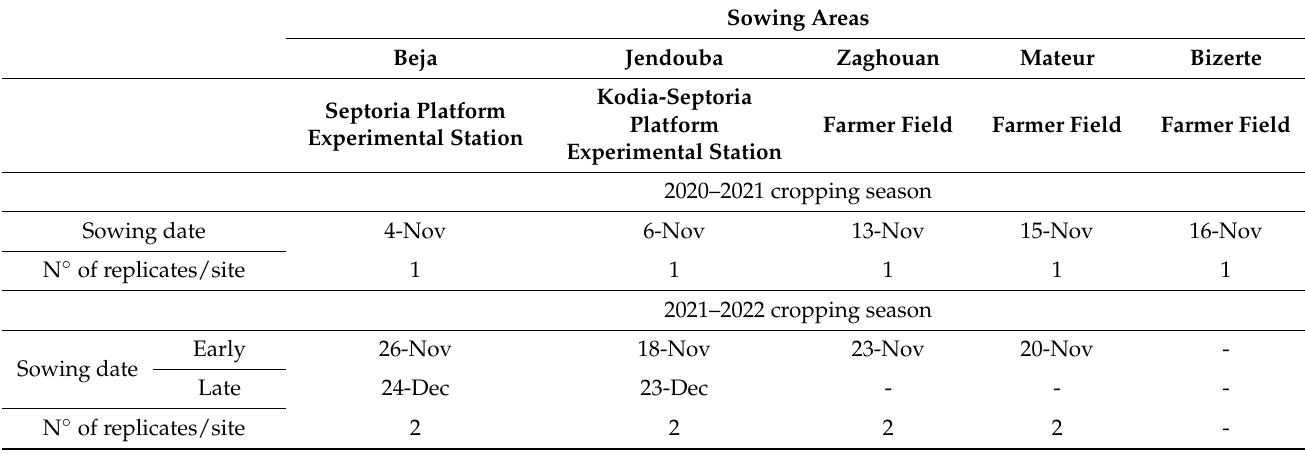
Table 2. Sowing areas and dates of the stem rust trap nurseries during the two successive